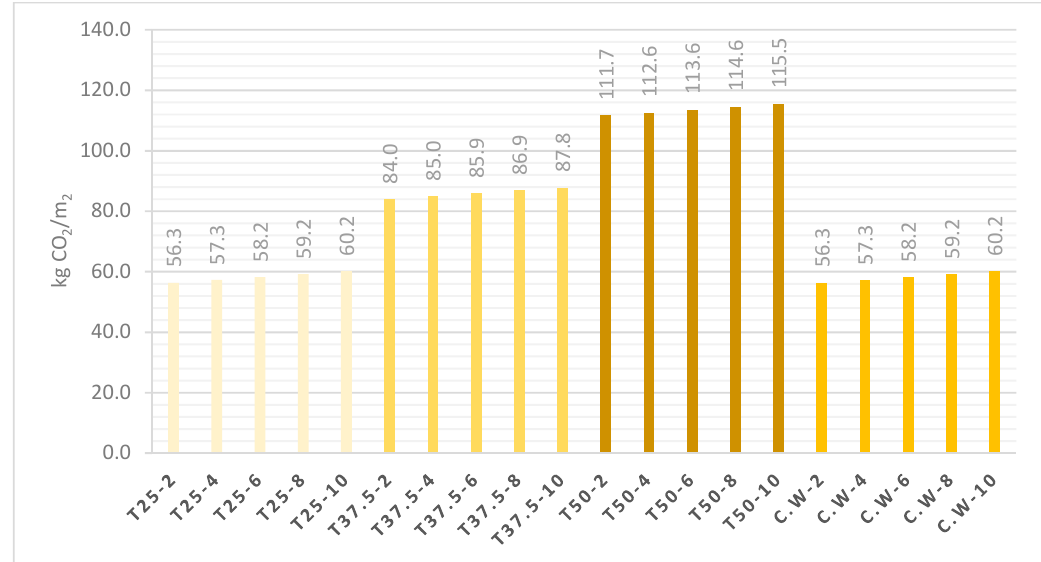
Figure A1. CO 2 emissions from the material manufacturing for the opaque alternatives.